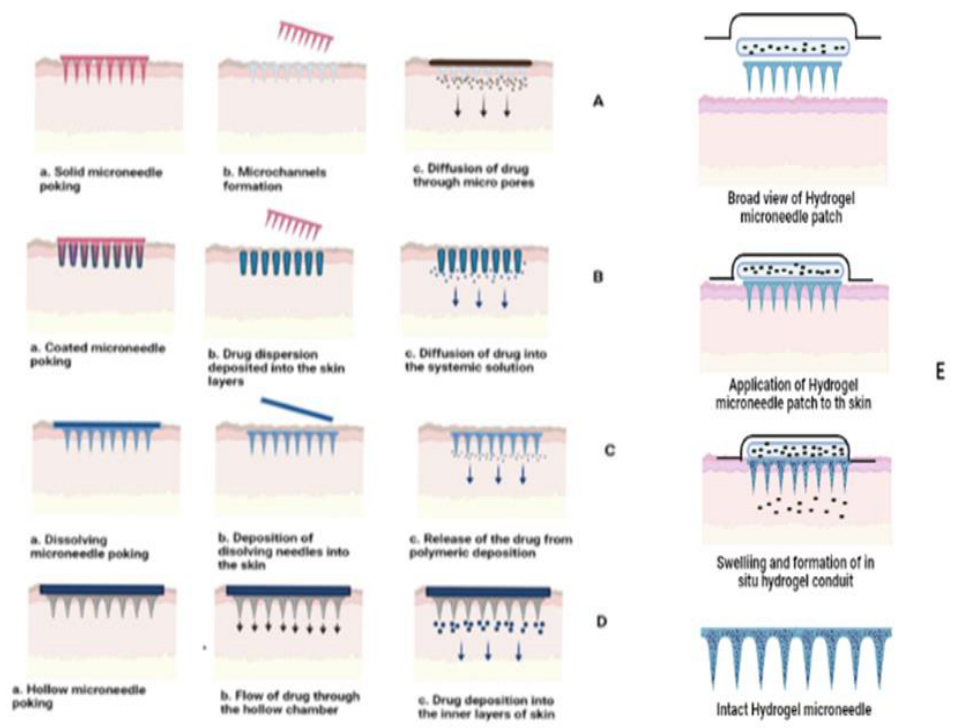
Figure 9. Microneedle approaches: ( A ) solid microneedles, ( B ) coated microneedles, ( C ) dissolving microneedles, ( D ) hollow microneedles, and ( E ) hydrogel microneedles.